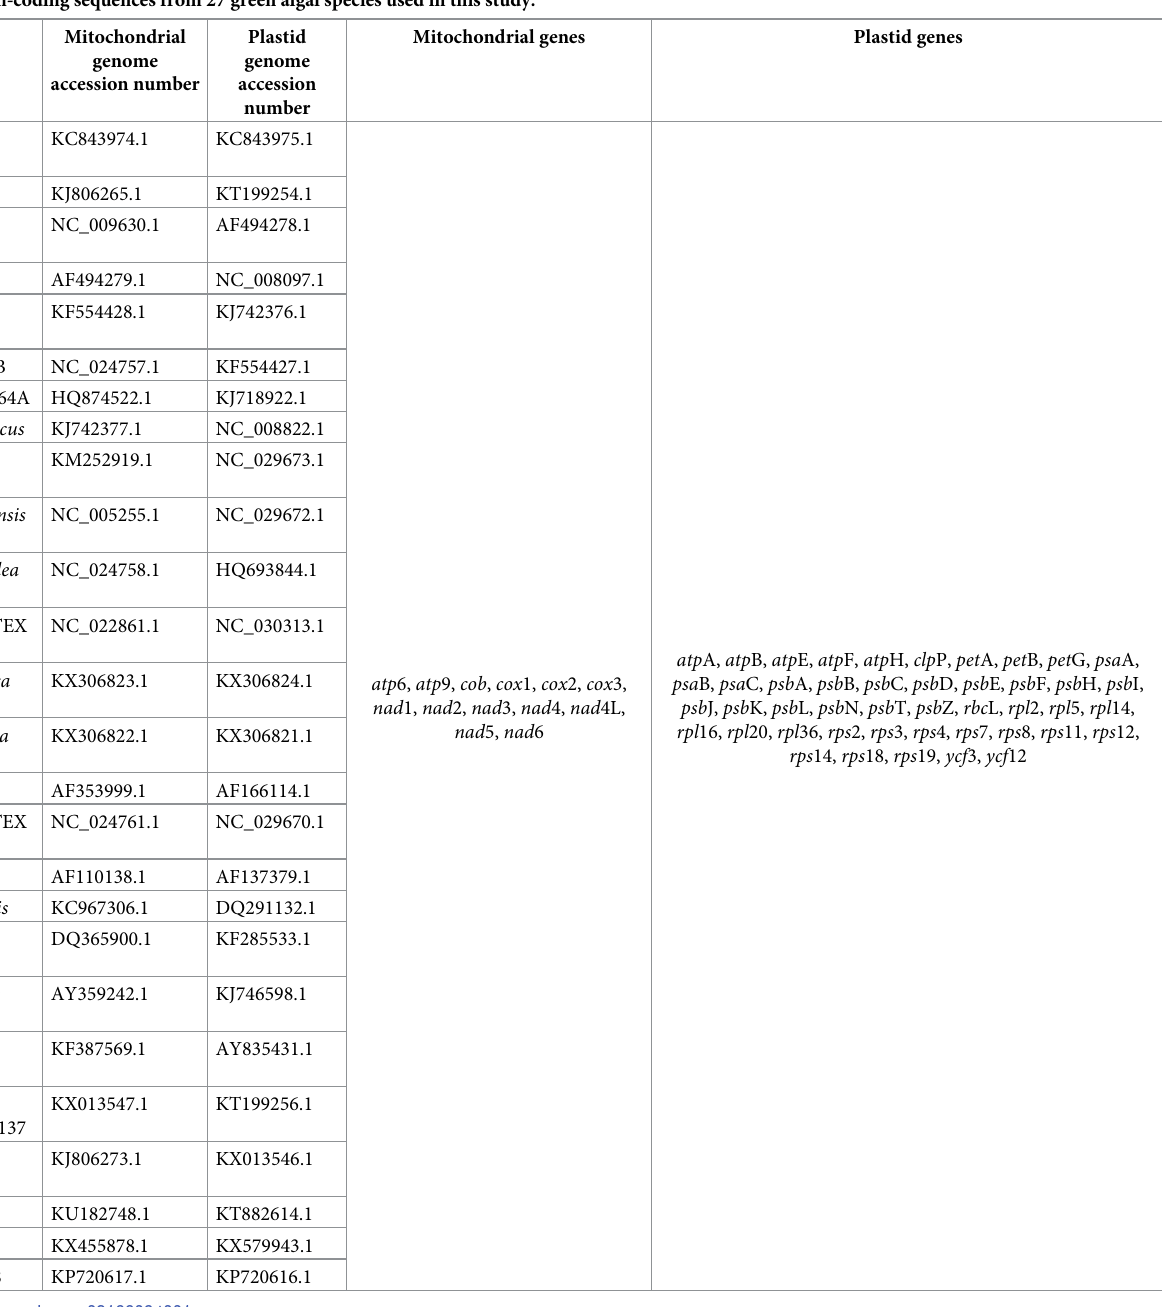
Table 1. List of protein-coding sequences from 27 green algal species used in this